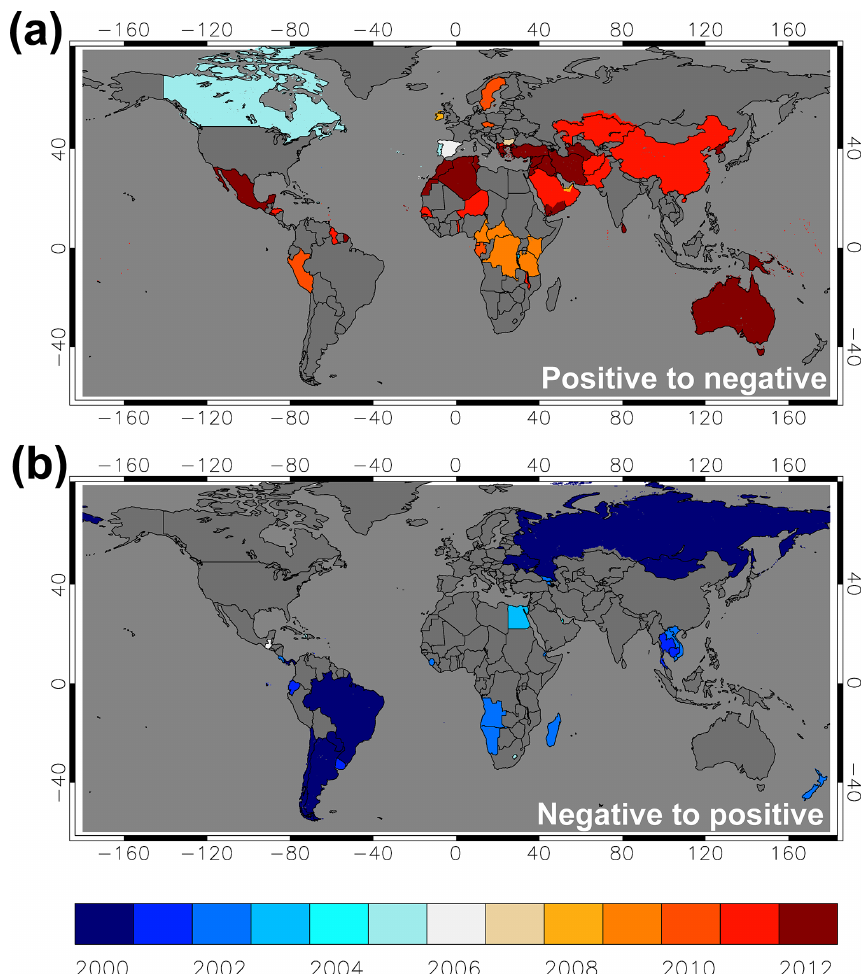
Figure 7. Year of tropospheric NO 2 VCD trend reversal from positive to negative (a) and from negative to positive (b) on a country level. Only countries with a statistically significant trend at the 95% confidence level for the period before or after the year of reversal are